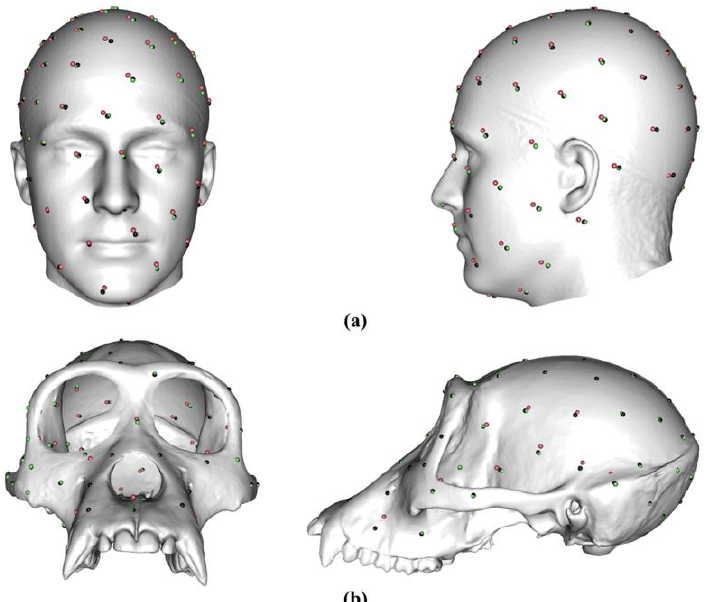
Figure 2. One hundred semilandmarks generated by the sliding TPS (black points), LS&ICP (red points), and TPS&NIPC (green points) approaches. ( a ) Mean adult human head. ( b ) Mean ape cranium.